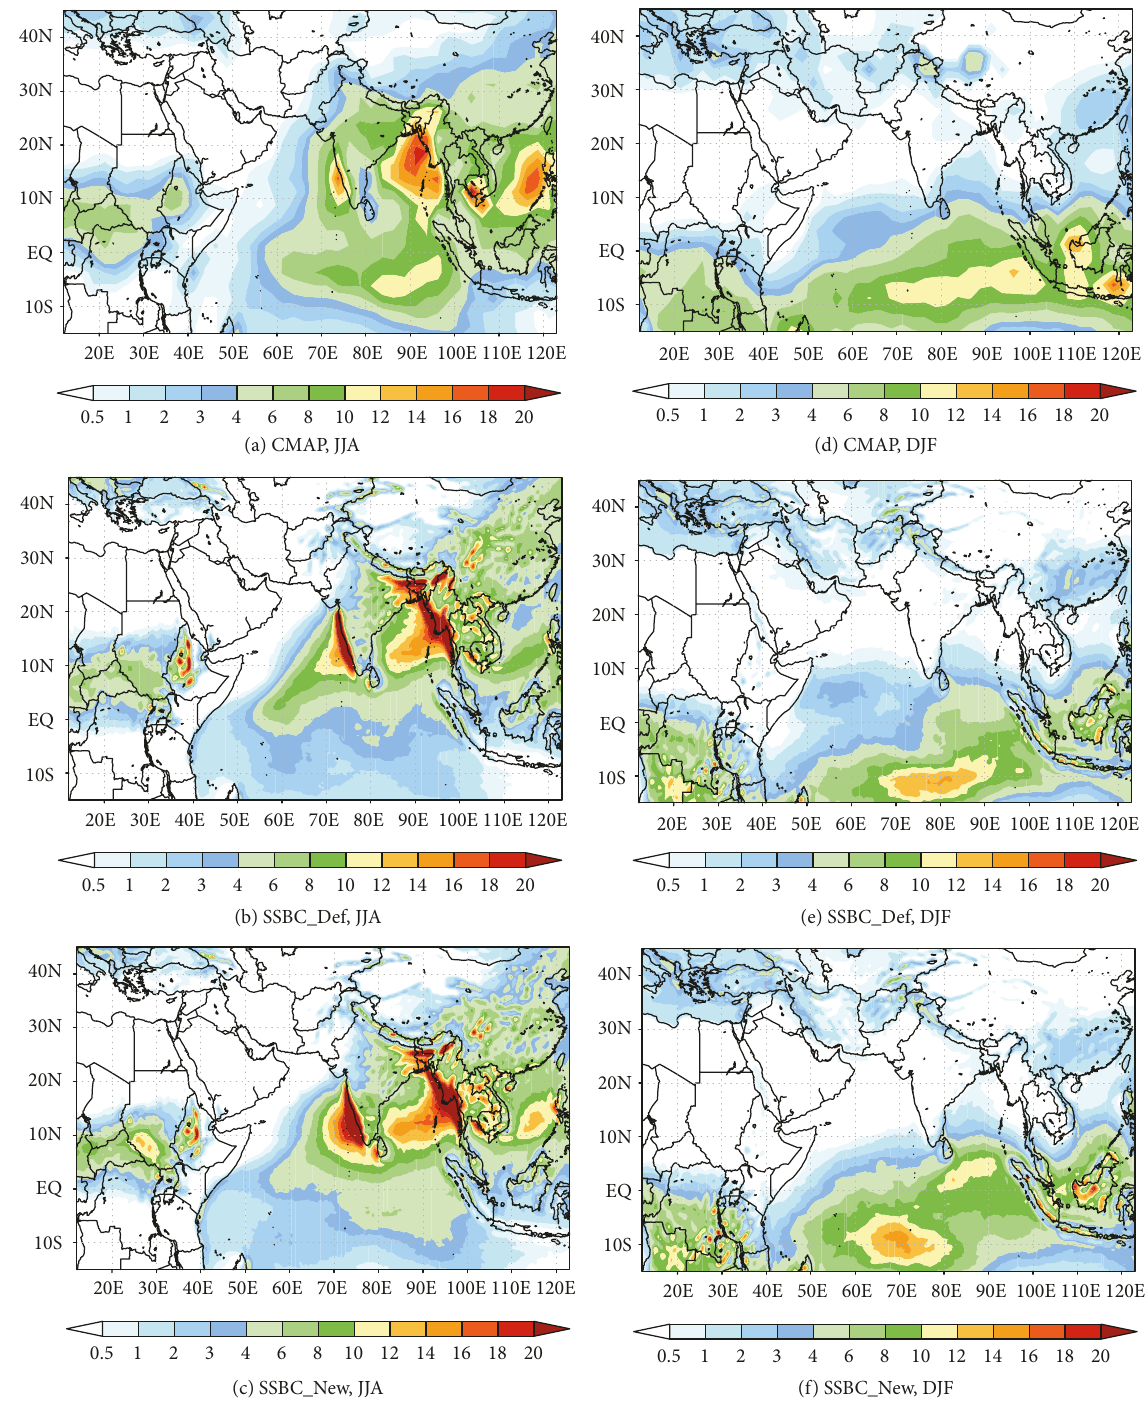
Figure 4: Seasonally averaged surface precipitation (mmd −1 ) for (a) CMAP, (b) SSBC_Def, and (c) SSBC_New June-July-August (JJA), 1981–1990. (d), (e), and (f) are the same as (a), (b), and (c) but for December-January-February (DJF), 1981–1990,